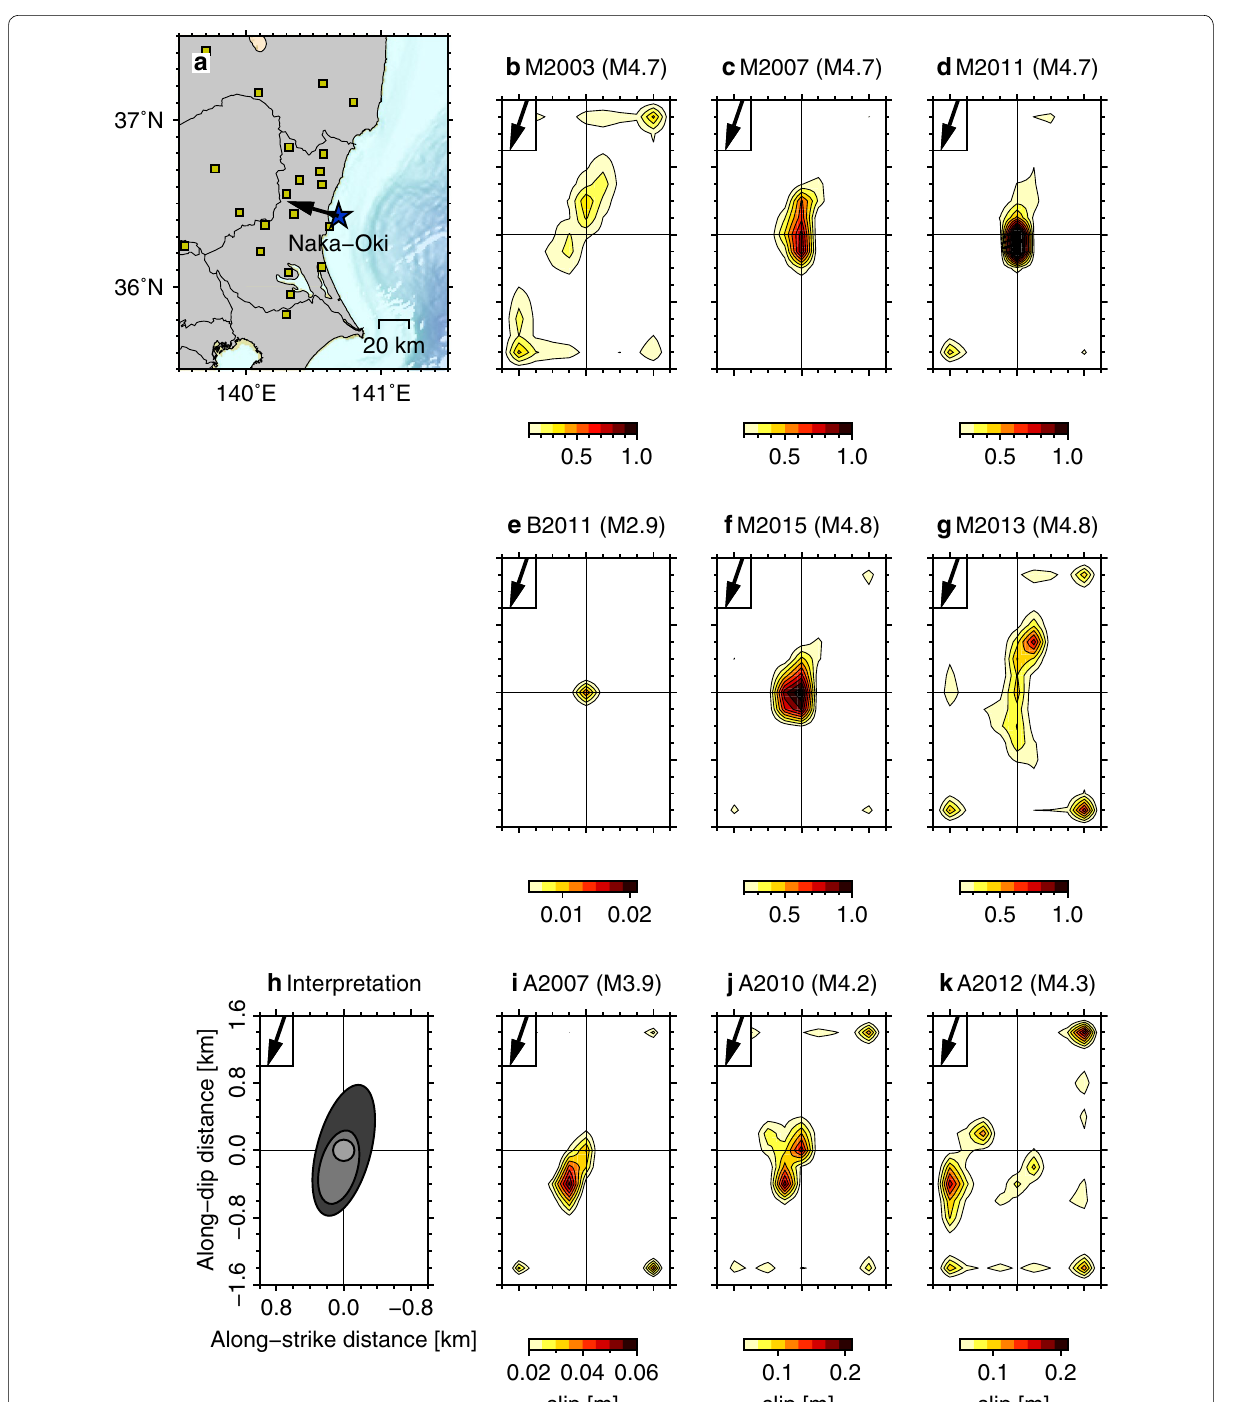
Fig. 8 Total slip distributions of the Naka-Oki earthquakes. a Map showing the locations of stations (yellow squares) used in the waveform inversion, relative to the Naka-Oki events (blue star), with the slip direction indicated by the black arrow. The total slip distributions of M2003 ( b ), M2007 ( c ), M2011 ( d ), M2013 ( g ), M2015 ( f ), B2011 ( e ), A2007 ( i ), A2010 ( j ), and A2012 ( k ), projected onto common spatial coordinates.